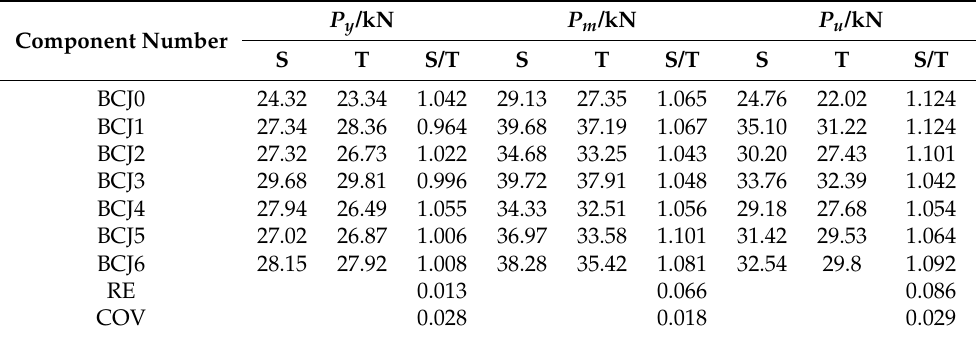
Table 1. Comparisons between simulated and experimental values.